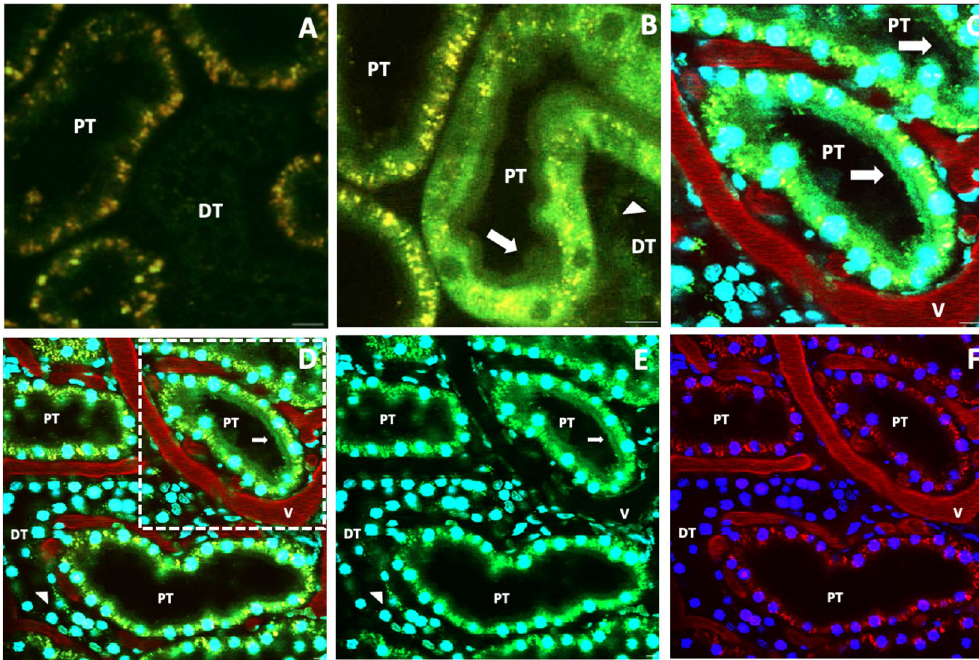
Figure 2. HGD allowed the visualization of the actin-rich renal brush border in vivo. ( A ) (taken at 2× optical zoom) shows innate autofluorescent patterns that are used to routinely distinguish the proximal tubule (PT) from the distal tubule (DT) segments but were unable to outline brush border segments. In comparison, ( B and C ) (taken at 2× optical zoom), as well as ( D and E ) (taken at 1× optical zoom), highlight the presence of the actin-rich brush border in vivo (identified by arrows) in the proximal tubule. The region outlined in ( D ) (dashed-line) is presented as ( C ), to focus on the brush border as we did in ( B ). ( A and B ) were formed by merging the green- and red-pseudo-color channels, while ( C and D ) were formed by merging the blue-, green- and red-pseudo-color channels. We presented different combinations of the pseudo-channels shown in ( D ) to create ( E and F ), to better highlight EGFP-actin expression in the tubules. Specifically, ( E ) was created by merging the green- and blue-pseudo-colors, and ( F ) was created by merging the blue- and